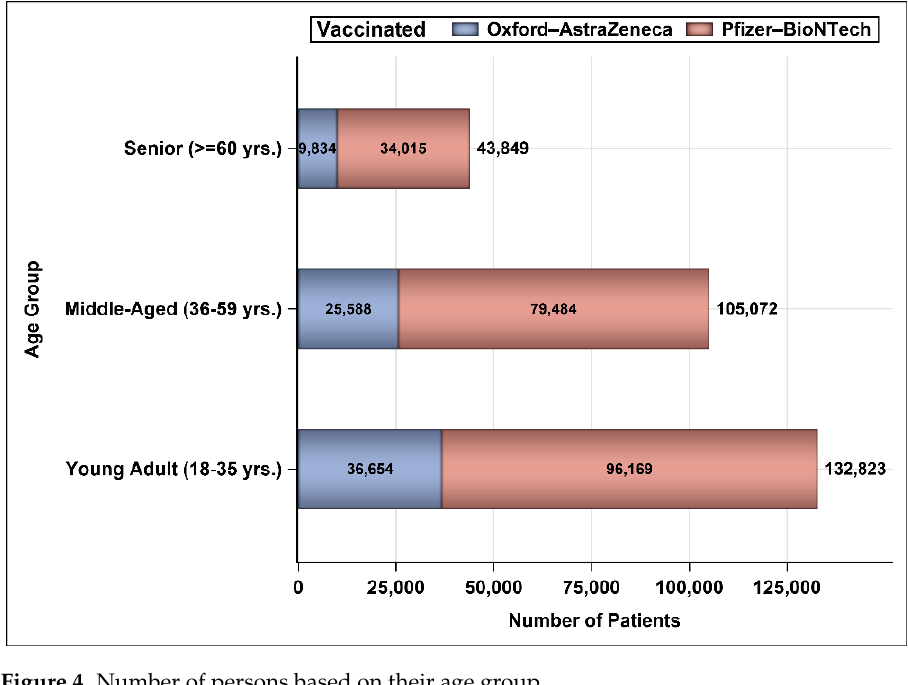
Figure 4. Number of persons based on their age group.